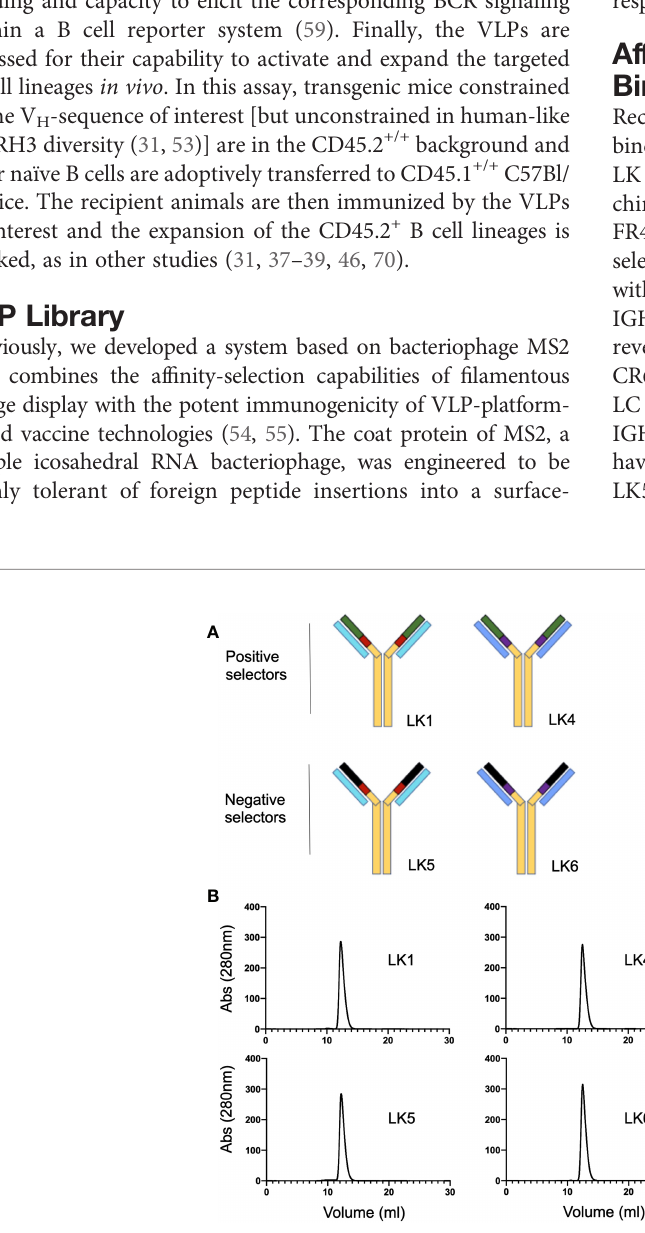
FIGURE 2 | Engineering chimeric antibody loop display for positive and negative selection. (A) Chimeric ‘ LK ’ mAbs were assembled using human IgG1 and displayed chimeric antigen binding sites: 1) LK1= gHgL VRC01 [IGHV1-2*02 + VRC01 CDRH3 and FR4 paired with V L gene-reverted VRC01 LC]; 2) LK4 = IGHV1- 2*02 + [CR6261 CDRH3 and FR4] paired with V L gene-reverted CR6261 LC; 3) LK5 = IGHV3-23*01 + [VRC01 CDRH3 and FR4] paired with V L gene-reverted VRC01 LC; 4) LK6 = IGHV3-23*01 + [CR6261 CDRH3 and FR4] with V L gene-reverted CR6261 LC. (B) Size exclusion chromatography of the LK mAbs (Superdex 200 10/300 column). (C) Puri fi ed LK mAbs separated by SDS PAGE and stained with GelCode